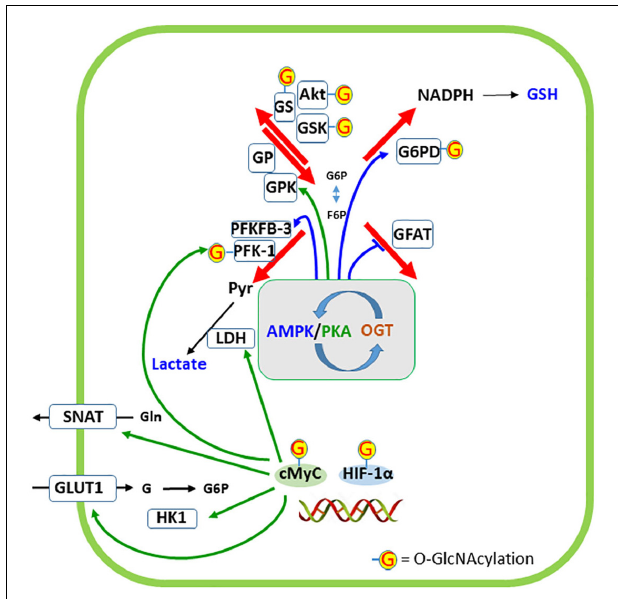
FIGURE 6 | Regulation of cellular destinations of glucose by O-GlcNAc modification of proteins. AMP-activated protein kinase (AMPK) and protein kinase A (PKA) have a narrow interaction in the regulation of glucose metabolism as well as phosphorylate and are targets of O-GlcNAc transferase (OGT). The phosphorylation of specific targets of AMPK or PKA in the four cellular destinations of glucose are indicated by the respective colored arrows. Targets of OGT are indicated by G. Two transcription factors closely related to glucose metabolism (cMyc and HIF-1 α ) are represented at the double-strand DNA and five proteins whose expressions are regulated by these transcription factors are indicated. G6PD, glucose-6-phosphate dehydrogenase; GFAT, glutamine:fructose-6P aminotransferase; GLUT1, glucose transporter 1; GP, glycogen phosphorylase; GPK, glycogen phosphorylase kinase; GS, glycogen synthase; GSK, glycogen synthase kinase; HIF-1 α , hypoxia-inducible factor-1 α ; HK1, hexokinase 1; LDH, lactate dehydrogenase; PFK-1, phosphofructokinase 1; PFKFB-3, 6-phosphofructo-2-kinase/fructose-2,6-bisphosphatase-3; SNAT, sodium-neutral amino acid transporter (type 3 or 5, in